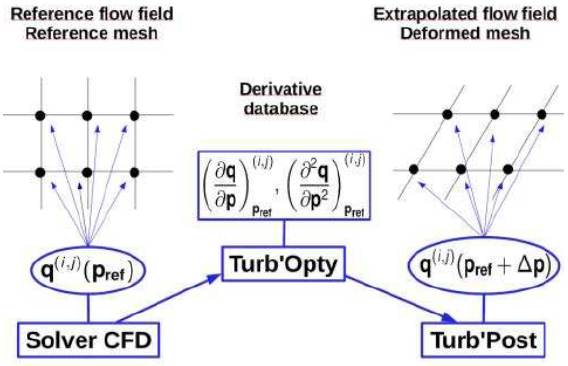
Figure 1. Diagram of parametrization process (Ref: [19]).